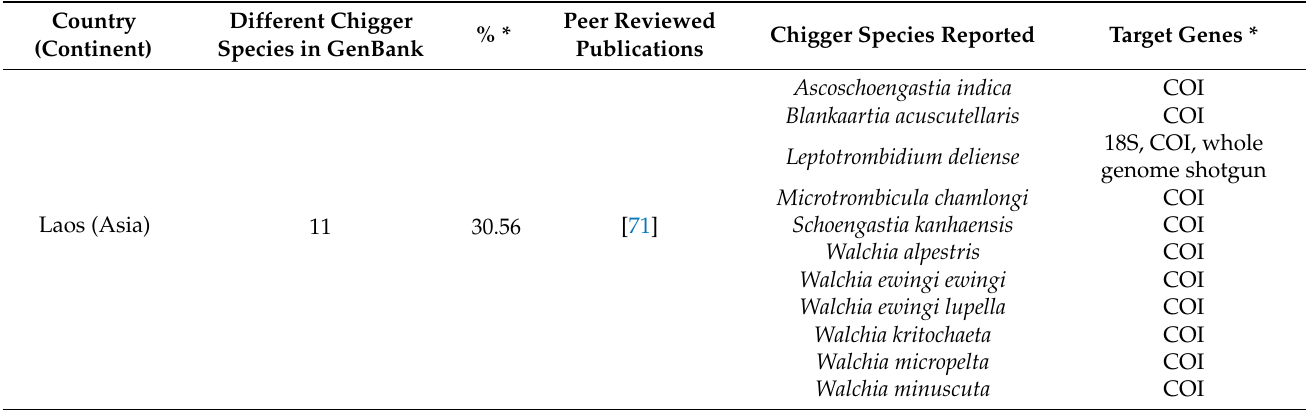
Table 1. Summary of chigger molecular data in GenBank in peer-reviewed